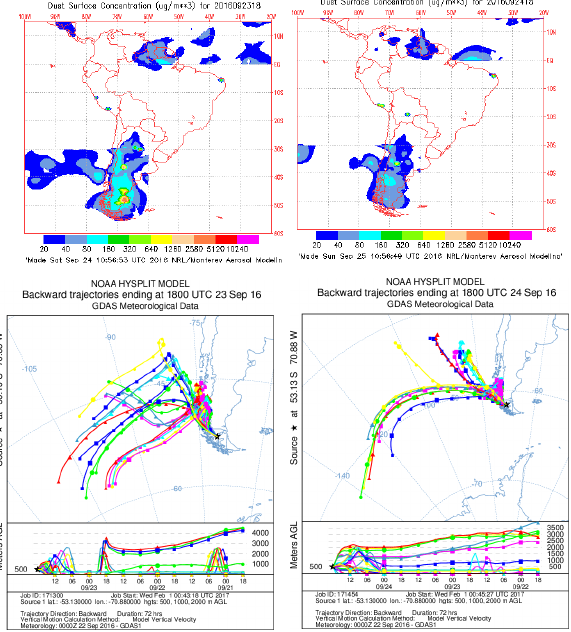
Figure 2 NAAPS forecasting analysis and HYSPLIT for the days 23 and 24 September 2016 at 18:00